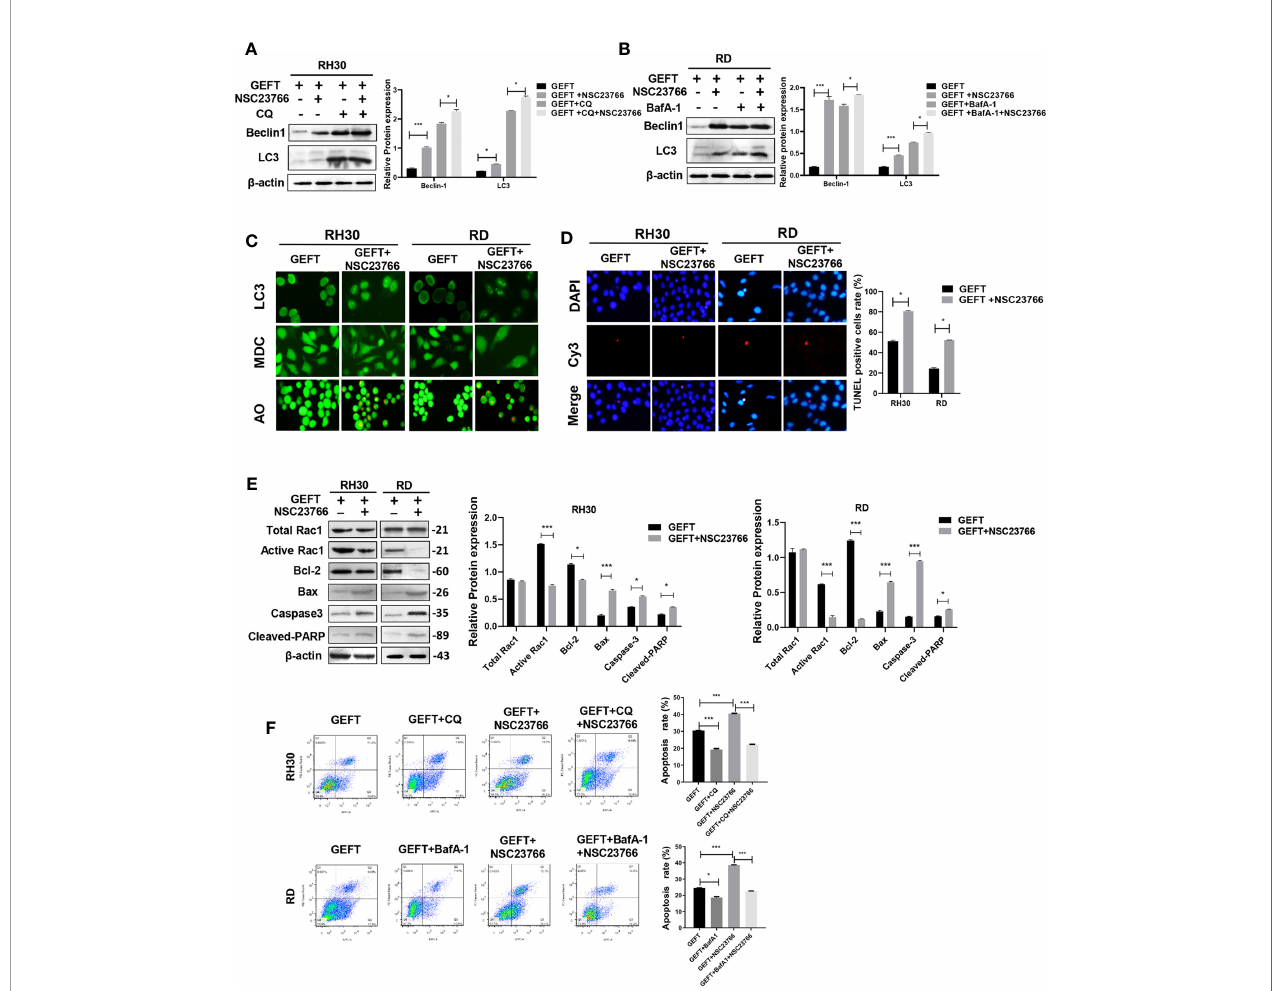
FIGURE 3 | GEFT can inhibit autophagy and apoptosis in RMS cells via Rac1. (A) Western blotting was used to detect the expression of Beclin1 and LC3 protein in RH30 cells transfected with GEFT, GEFT+NSC23766, GEFT+CQ, and GEFT+CQ+NSC23766. (B) Western blotting was used to detect the expression of Beclin1 and LC3 protein in RD cells transfected with GEFT, GEFT+NSC23766, GEFT+BafA-1, and GEFT+BafA-1+NSC23766. (C) The representative images of RH30 and RD cells transfected with GEFT and GEFT+NSC2376 were detected by immuno fl uorescence, MDC and AO staining. (D) The representative images of RH30 and RD cells transfected with GEFT and GEFT+NSC2376 were detected by TUNEL staining. (E) Western blotting was used to detect the expression of GEFT, Total Rac1, Active Rac1, Bax, Bcl-2, Caspase-3, and Cleaved-PARP protein in RH30 and RD cells transfected with GEFT and GEFT+NSC23766. (F) Flow cytometry was used to detect the apoptosis of RH30 cells and GEFT-transfected RH30 cells in GEFT, GEFT+CQ, GEFT+NSC23766 and GEFT+NSC23766+CQ groups. Flow cytometry was used to detect the apoptosis of RD cells and GEFT-transfected RD cells in GEFT, GEFT+BafA-1, GEFT+NSC23766 and GEFT+NSC23766+BafA-1 groups. *** P < 0.001, * P <